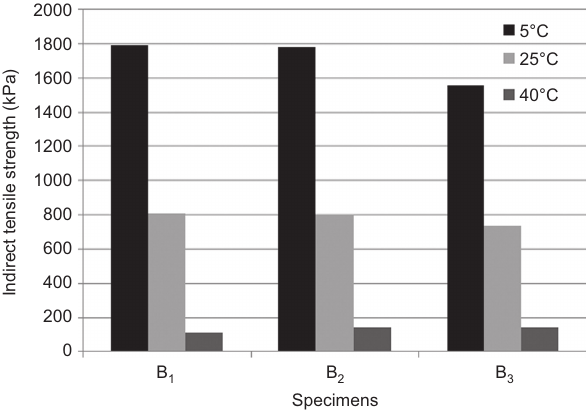
Figure 13 Variation of the indirect tensile strength of the B